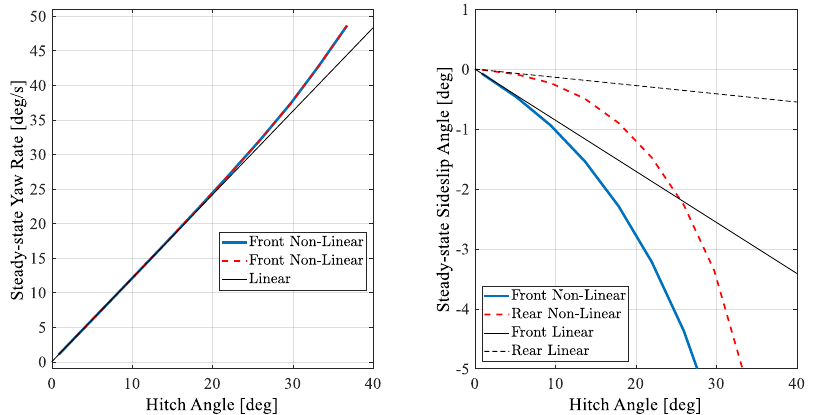
Figure 11. Steady--state yaw rate, front and rear sideslip angles characteristics for a constant longi- tudinal speed 𝑢 1 = 20 km/h.